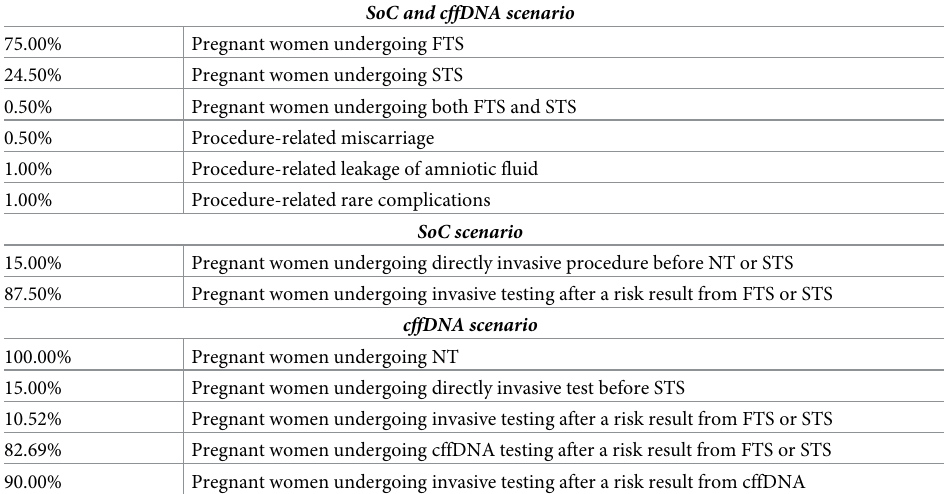
Table 3. Patient flow inputs and assumptions [17, 18, 19, 20, 21,22].